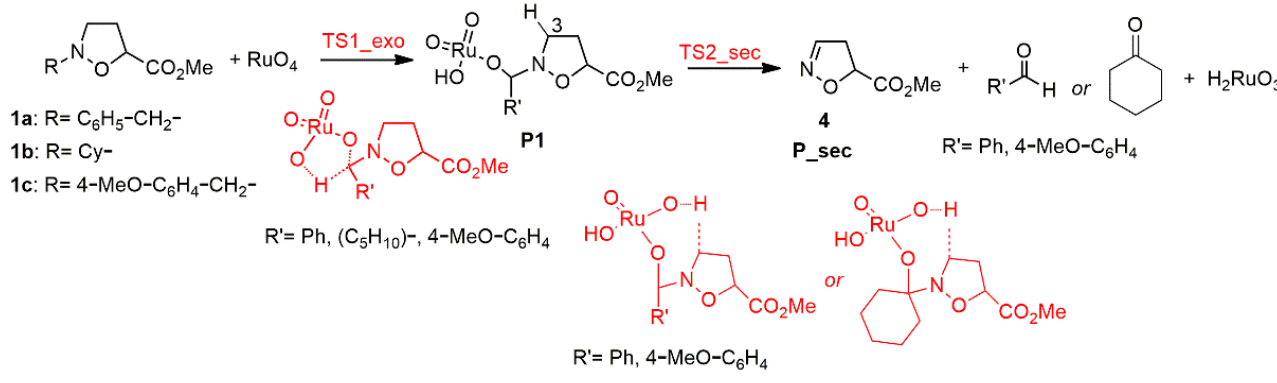
Figure 4. Three-dimensional plots of TS2 leading to P2 for compounds 1a – c . For TSs imaginary